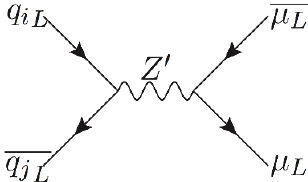
Figure 3 . Feynman diagram of tree-level Z 0 production in the LHC, where q i;j 2 f u; c; d; s; b g are such that the combination q iL q jL has zero electric